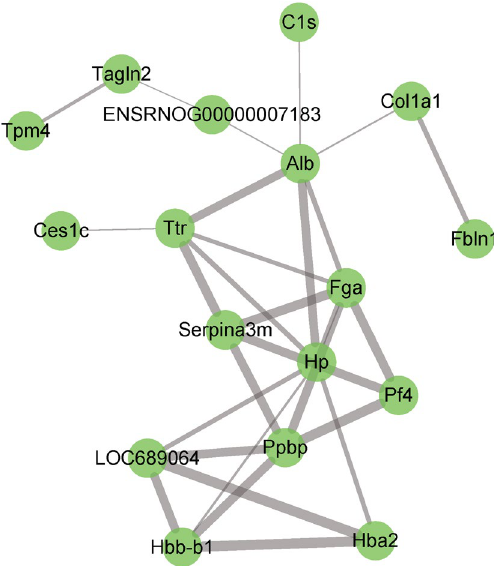
Figure 5. STRING analysis of the interactions between DEPs. α-1-acid glycoprotein, collagen, fibulin, haptoglobin, PLTP and TAGLN2 were identified at hub positions.